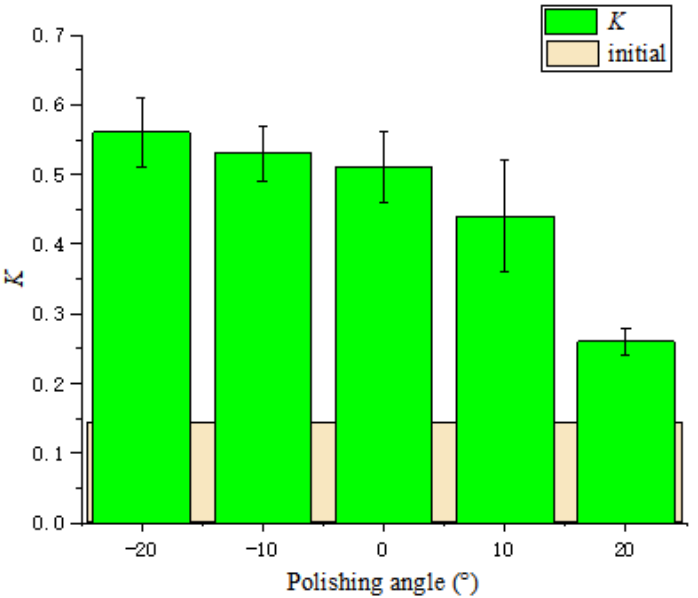
Figure 9. The change of the shape factor K with the polishing angle.